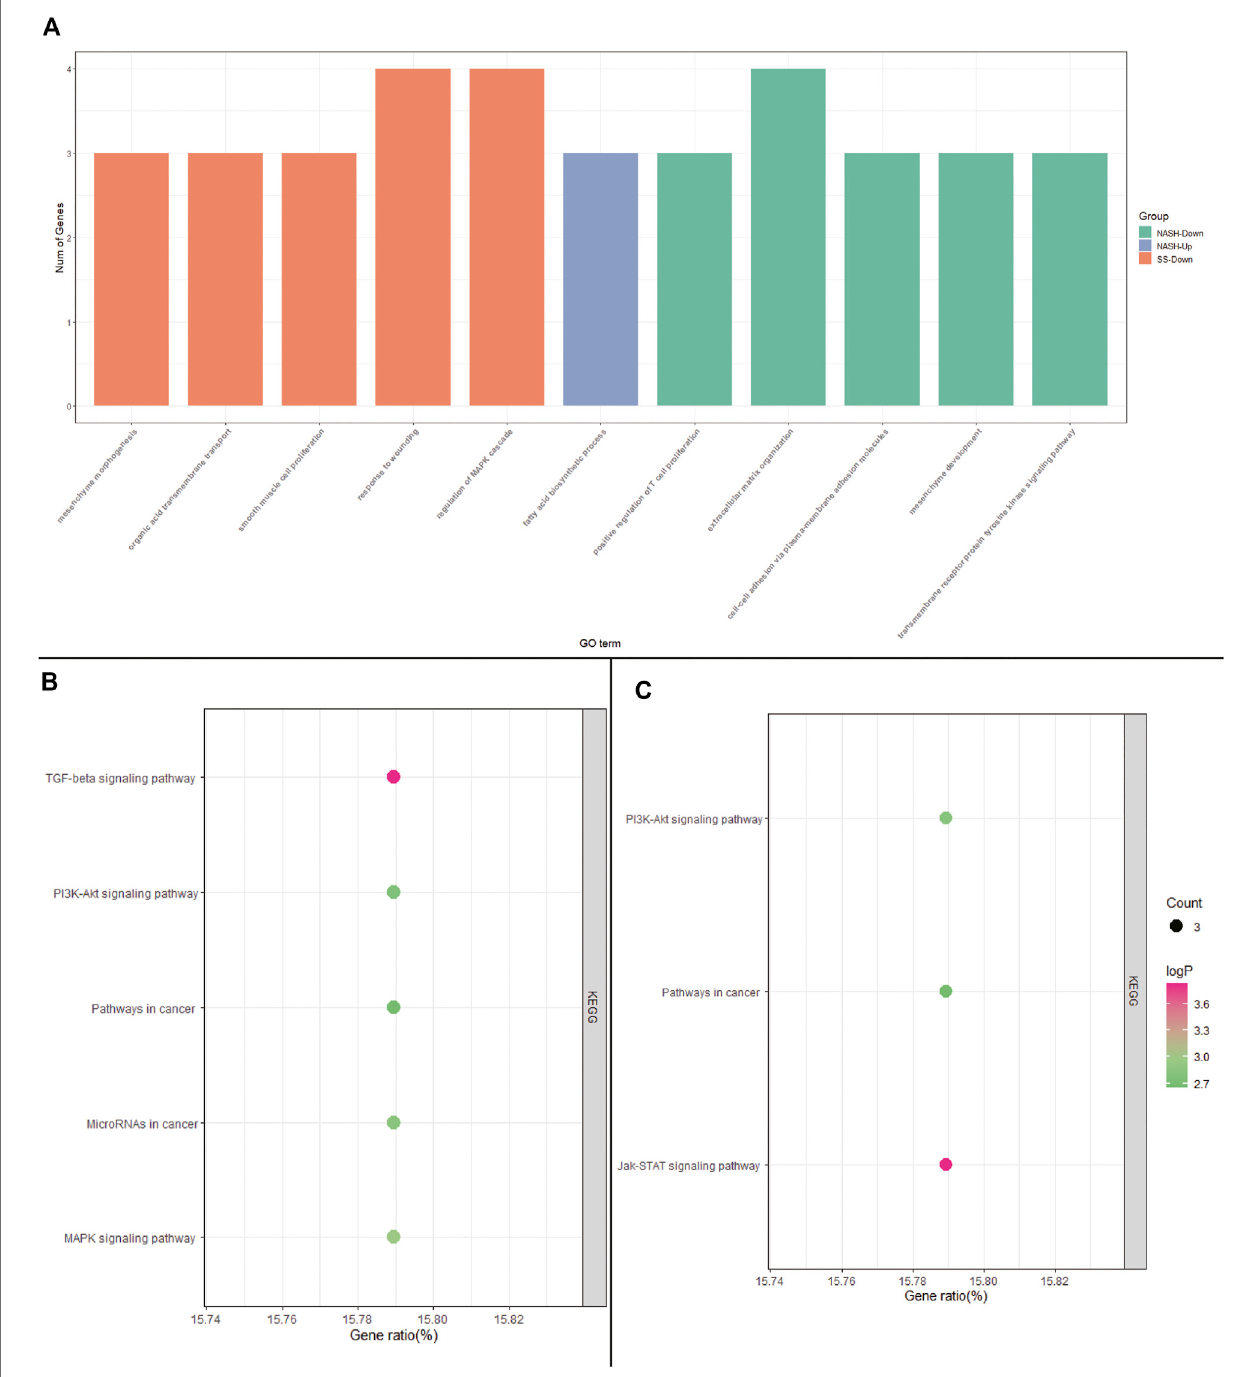
FIGURE 3 | GO and KEGG pathway enrichment analysis. (A) GO analysis of DEGs among HC, SS, and NASH; (B) KEGG analysis of down-regulated DEGs between HC and SS; (C) KEGG analysis of down-regulated DEGs between HC and NASH.